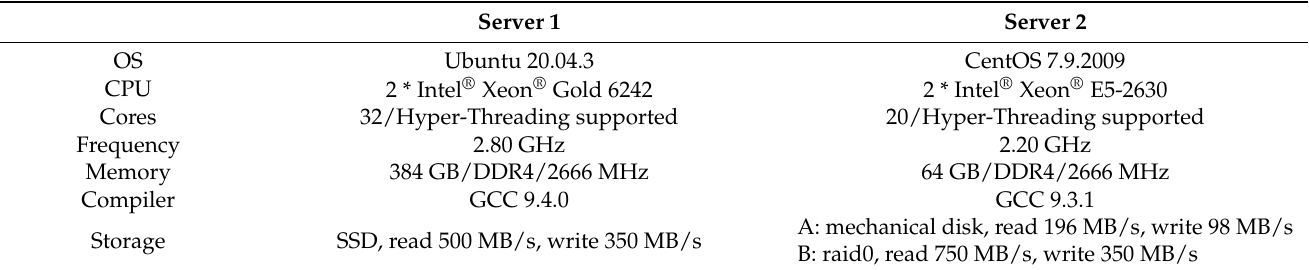
Table 5. Software and hardware configurations of the computing